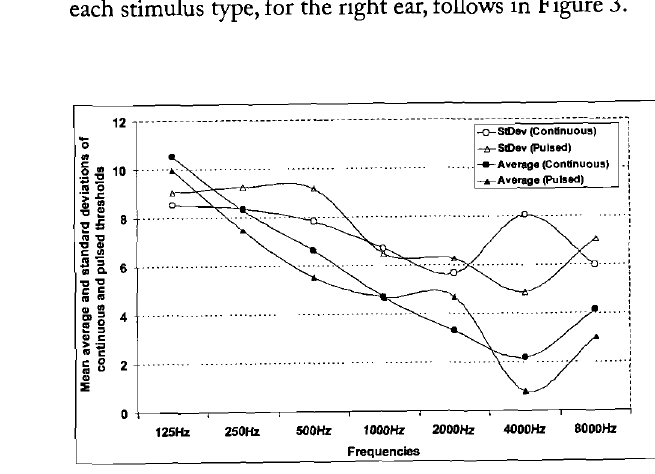
Figure 3: Mean averages and standard deviation for continu­ ous and pulsed tones in the right ear (n-18).